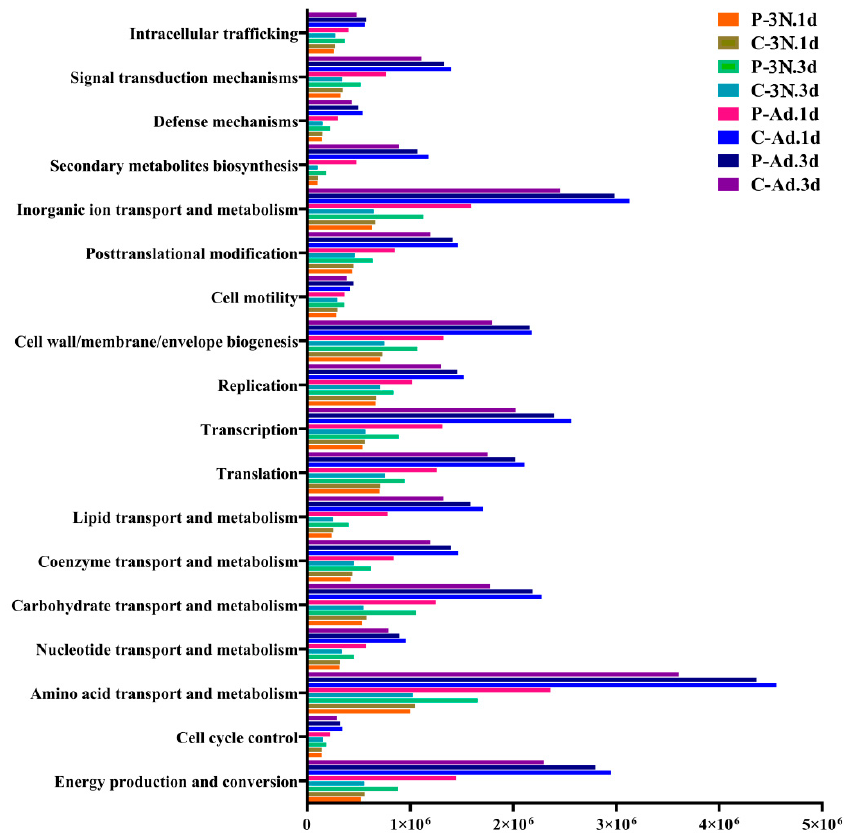
Figure 5. Comparison of COG (Cluster of Orthologous Groups) function prediction of microorgan- isms in ovaries at different developmental stages and times after treatment.